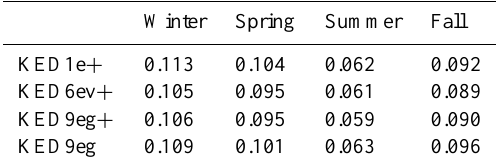
Table 7. Relative mean root-transformed error E calculated over all stations for different seasons using different interpolation models (see Table 1 for model